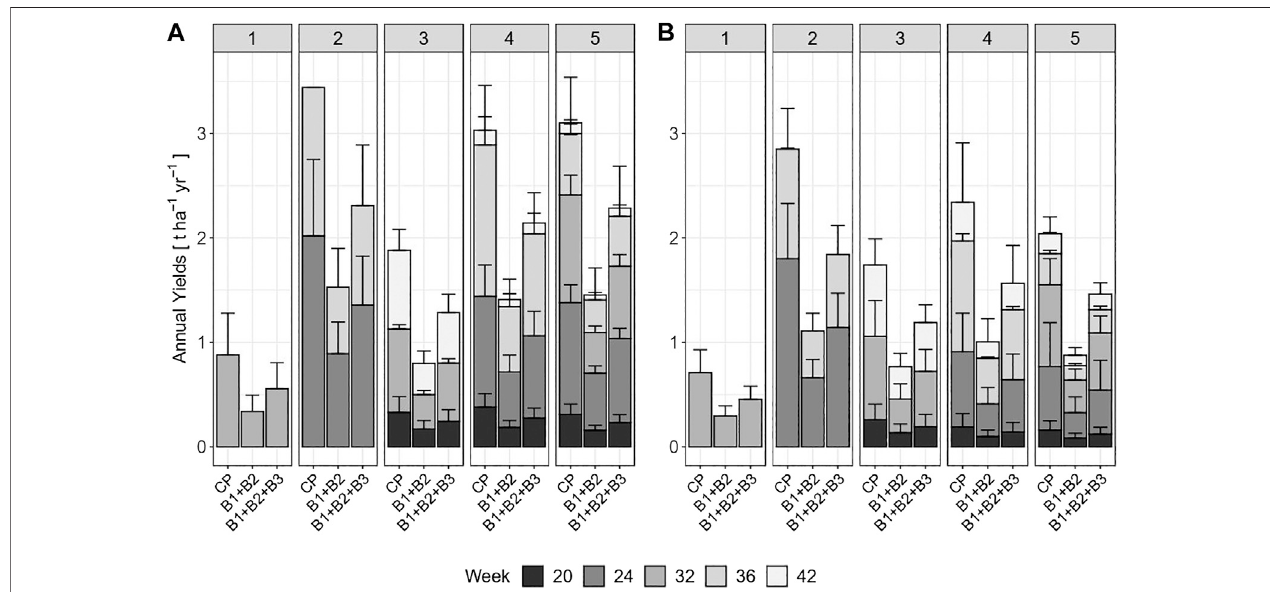
FIGURE5| Cumulativeannualyields(tha − 1 year − 1 )andyieldspercutofcrudeprotein(CP),proteinfractionsB 1 +B 2 ,andB 1 +B 2 +B 3 forthevarioustreatmentsin (A) reed canary grass, and (B) tall fescue. Error-bars show standard deviations.